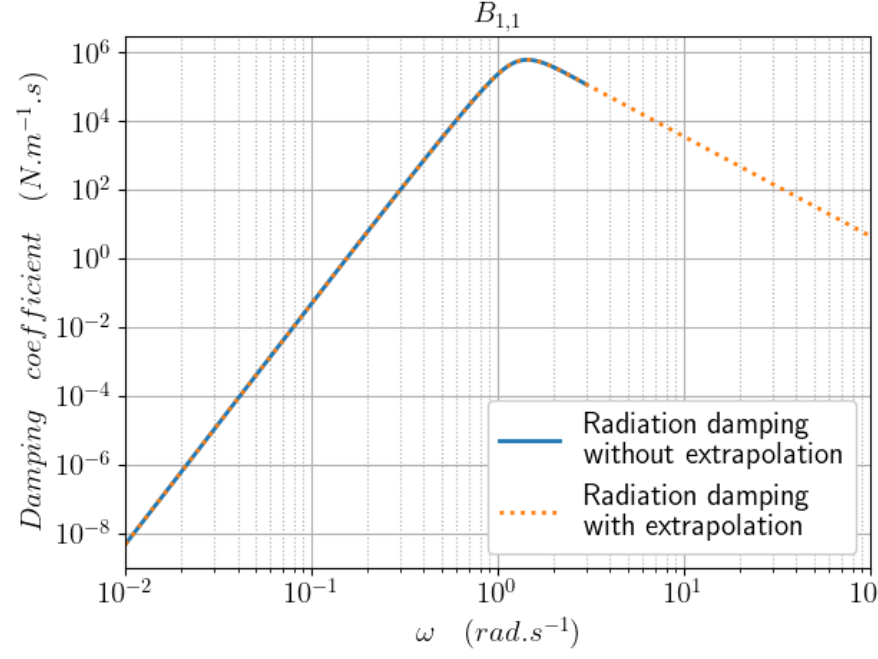
Figure 1. Example of extrapolation for B jk with j = k =